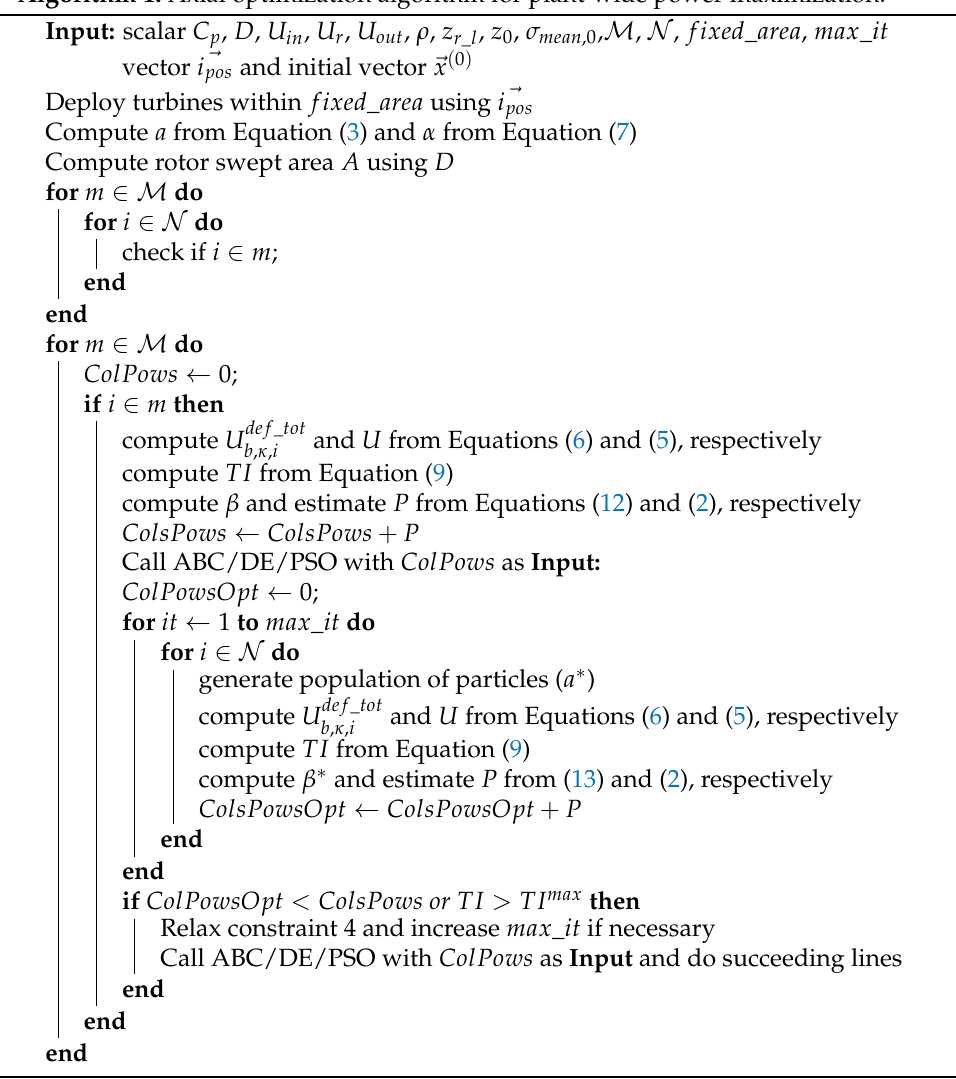
Algorithm 1: Axial optimization algorithm for plant-wide power